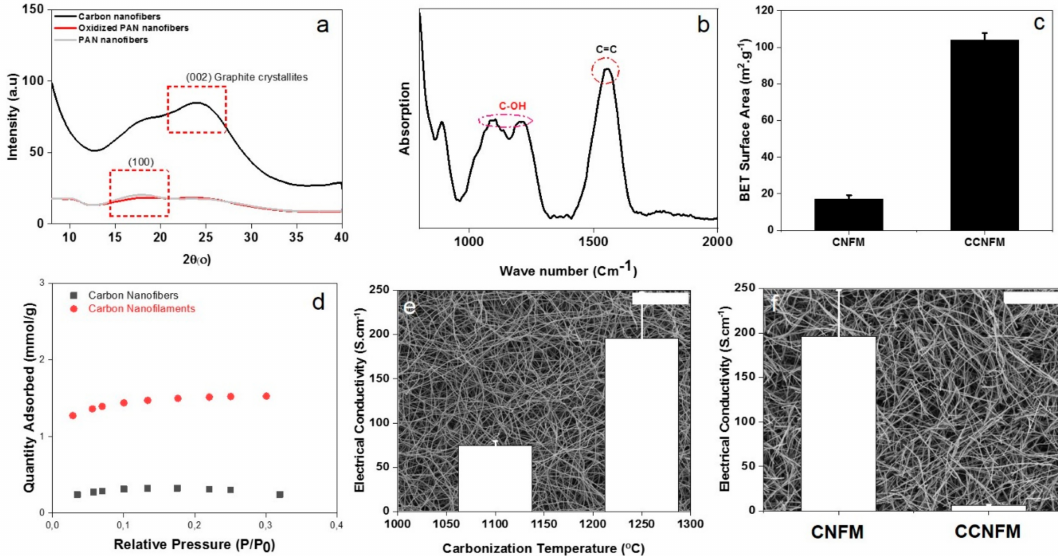
Figure 3. Structural properties of the a-CO x / G nanofilaments. ( a ) XRD verifying formation of graphite crystallites, along with a-CO x domains; ( b ) ATR-FTIR showing the surface chemistry of a-CO x / G nanofilaments; ( c ) Brunauer–Emmett–Teller (BET) surface area measured for the carbon nanofilament-based membrane (chopped carbon nanofilament membrane (CCNFM)) versus the carbon nanofiber-based membrane (carbon nanofiber membrane (CNFM)), stressing the e ff ect of the